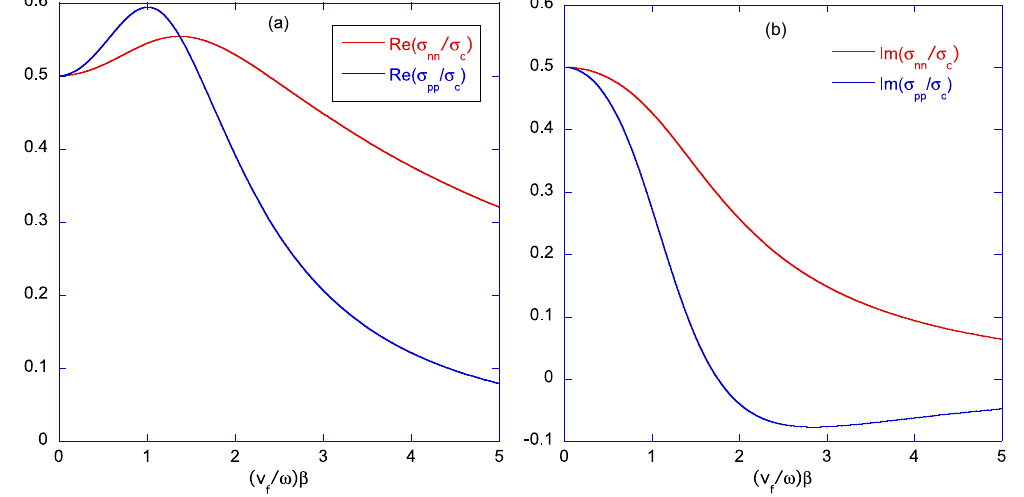
Figure 9. Real ( a ) and imaginary ( b ) parts of ),( / ω ) β for ν / ω = 1. vs. ( ν F